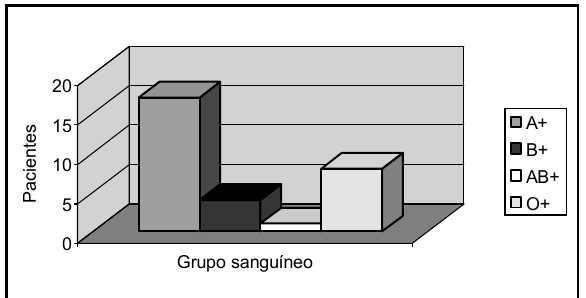
Figura 2 – Distribuição dos pacientes por grupo